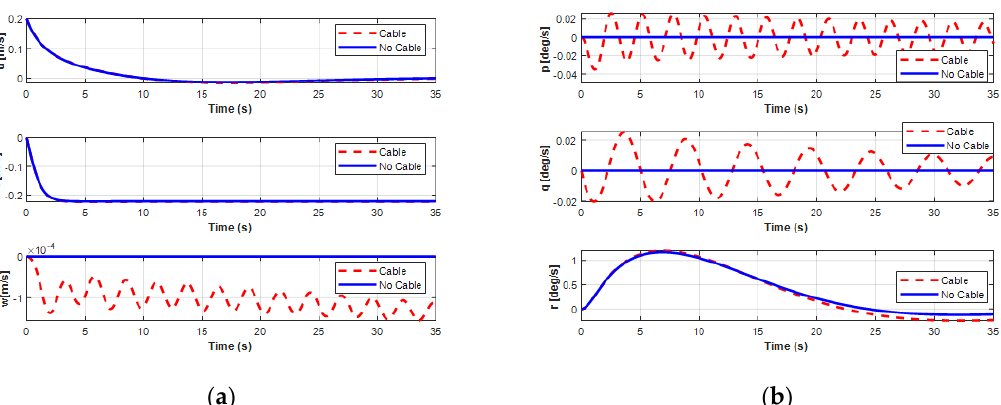
Figure 31. Simulation results of linear and angular velocities of the UUV doing the sideward motion: ( a ) linear velocities of the UUV; ( b ) angular velocities of the UUV.